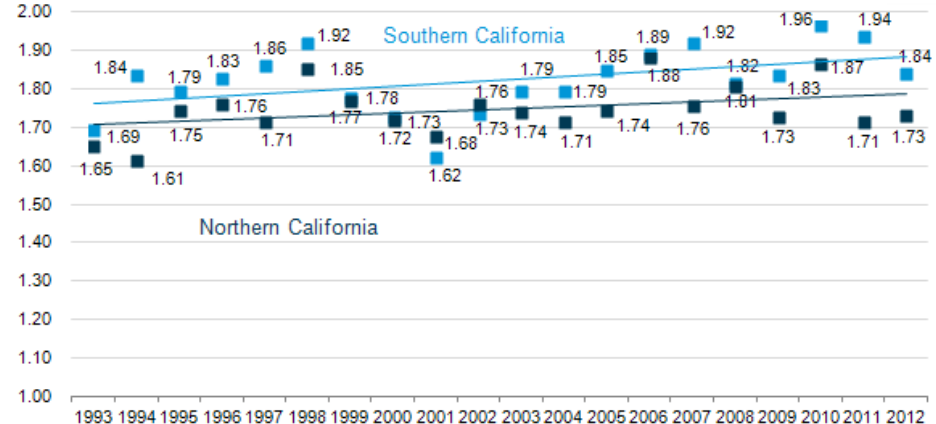
Figure 2. California’s peak to average electricity demand ratio has been generally rising in the past decade, particularly in Southern California, although it is highly dependent on yearly climate, housing stock and other economic conditions. Source: Energy Information Administration (EIA. 2016).